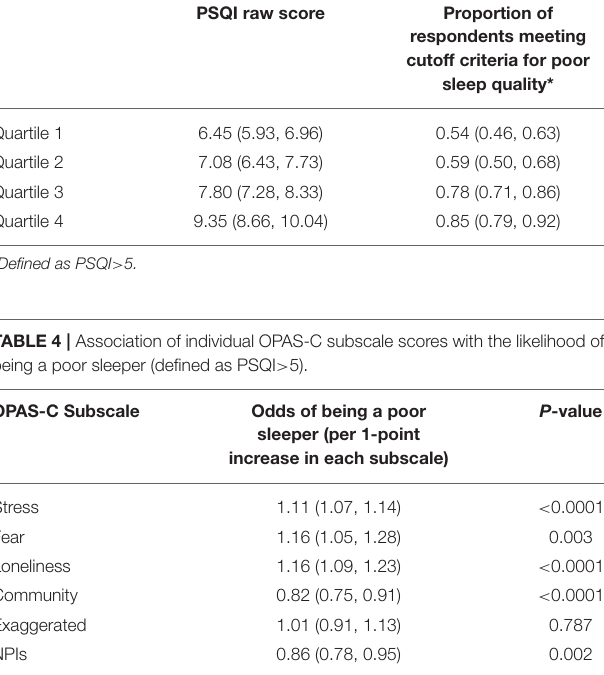
TABLE 2 | Demographic and characteristics of respondents, overall and by sleep quality status. Characteristic